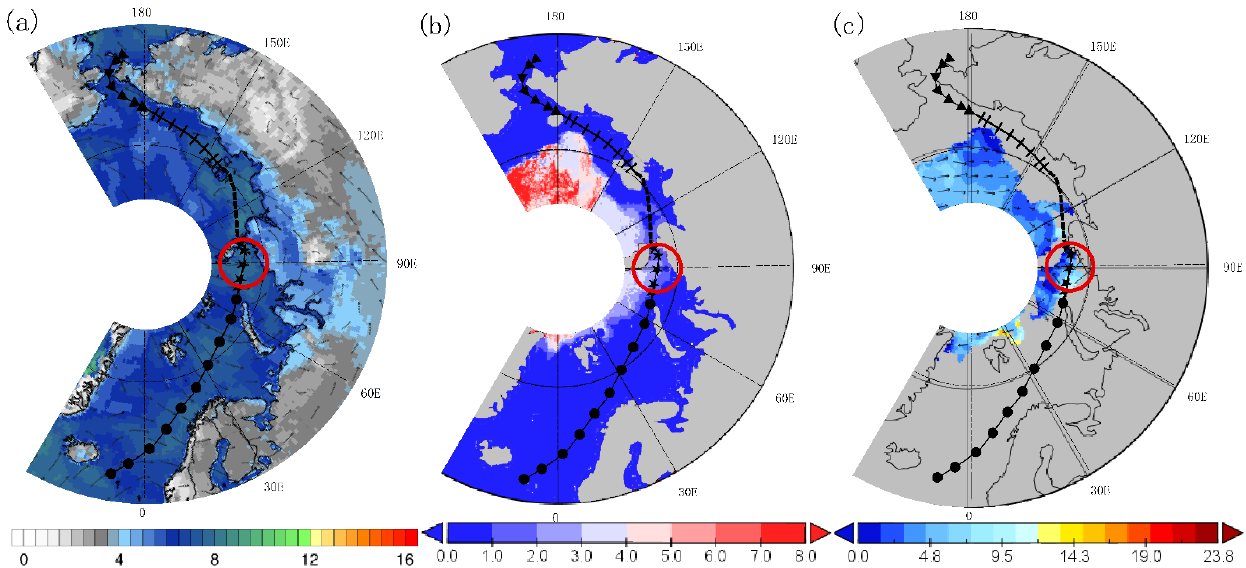
Figure 12. The average wind field ( a ), sea ice age ( b ) and sea ice movement ( c ) of the NEP in the Arctic in August 2002.